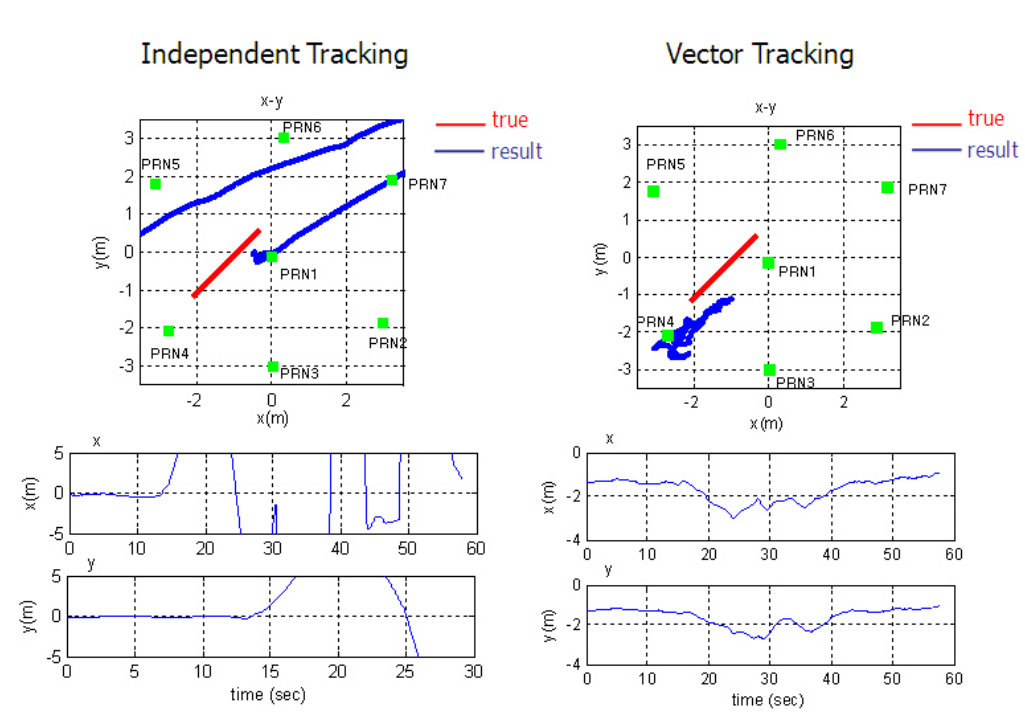
Figure 20. Navigation results: ITL (left) and VTL